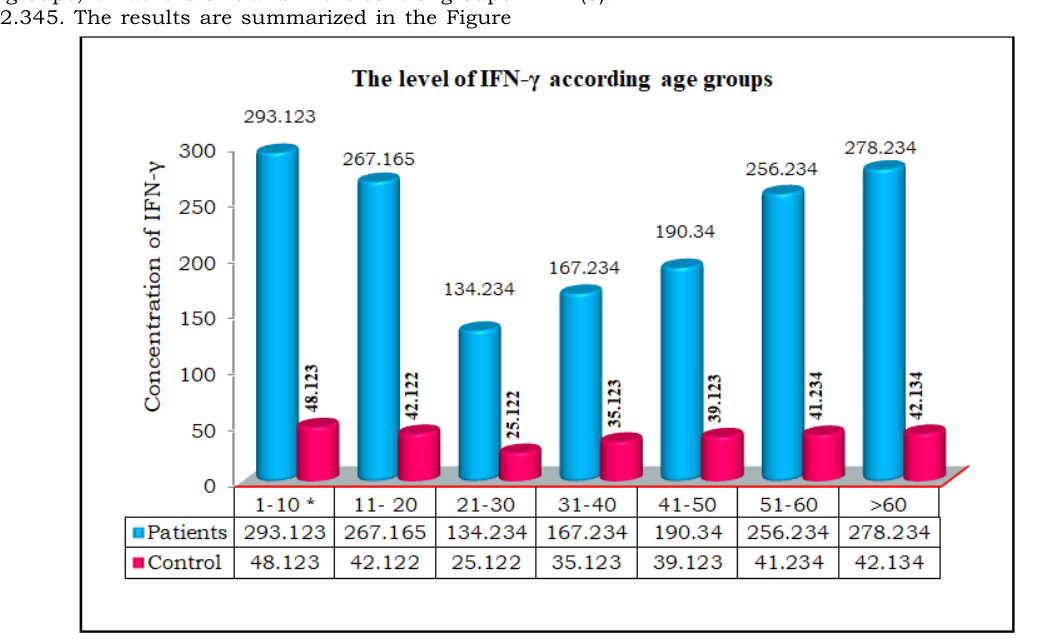
Fig. 7. Interferon gamma concentration (pg / ml) distributed according to the age groups for both patients and control groups